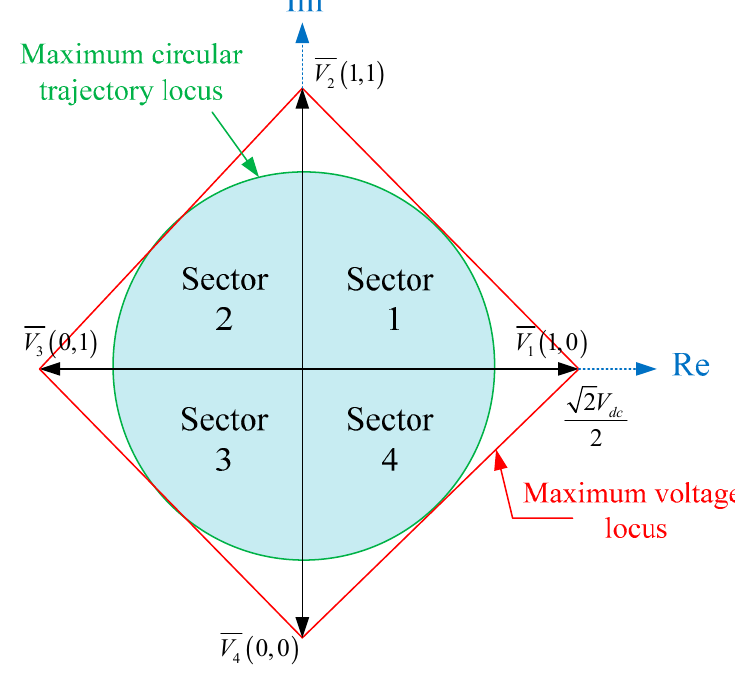
Figure 3. Space vectors for 2 ϕ -inverter.